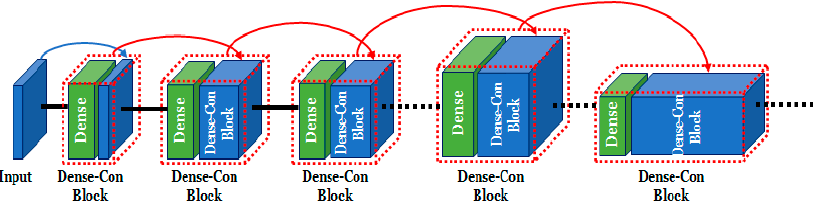
Figure 5. Network structure of nested block connection using the previous dense-concatenate block output as the input. Table 2. DeConNet architecture for MDCOVRPPD